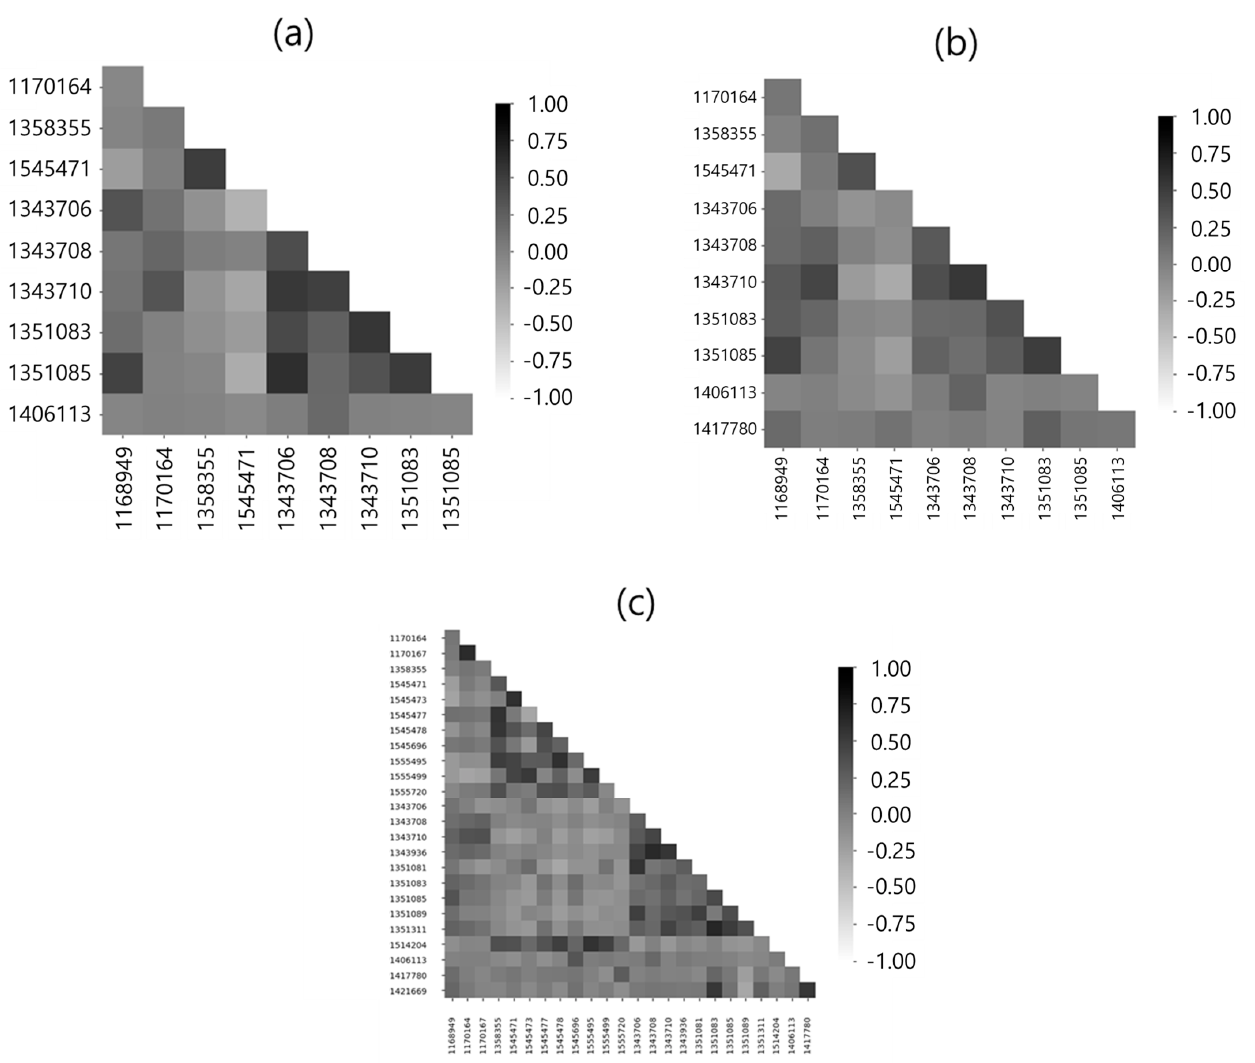
Figure 8. Correlation Coefficient Result: ( a ) Pearson; ( b ) Spearman; ( c ) Kendall tau.